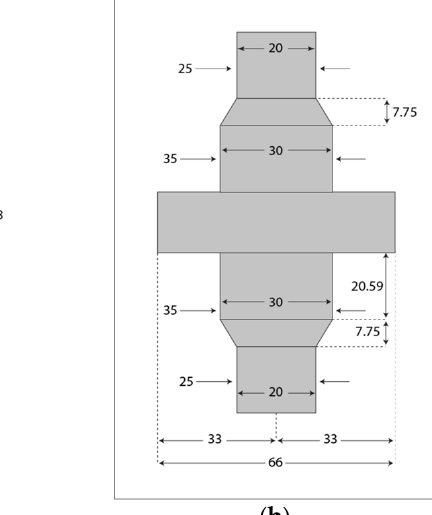
Figure 9. Second valve geometry. ( a ) Front view; ( b ) side view.